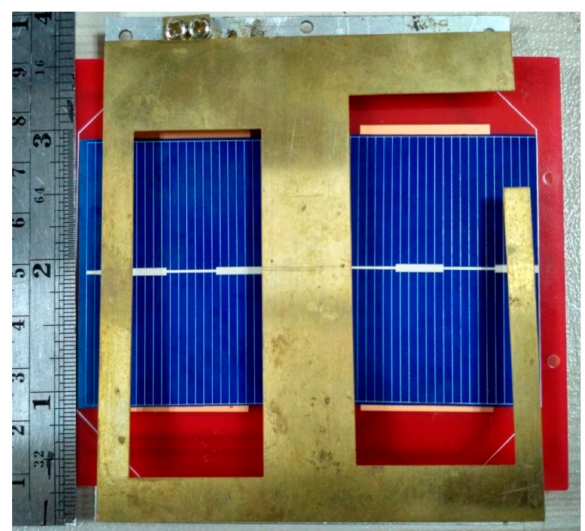
Figure 6. Fabricated prototype of the proposed antenna integrated with the solar panel; the solar panel is placed in between the radiating patch and ground plane.